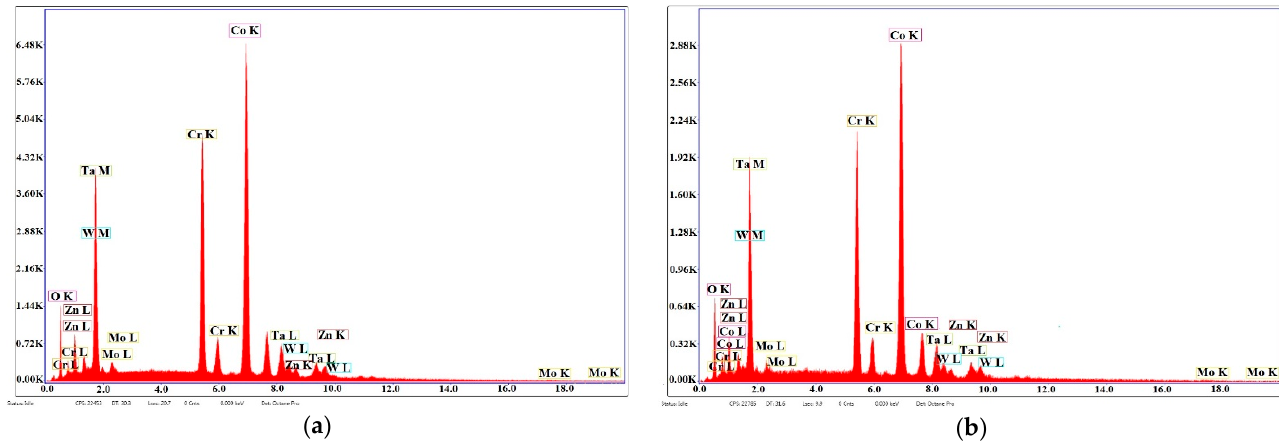
Figure 5. EDS analyses of Co-Cr alloy samples fabricated by DMLS and coated with composite thin film of Ta 2 O 5 (75%) and ZnO (25%) using an e-gun: ( a ) sample S3 with post-treatment; ( b ) sample S4 without post-treatment.